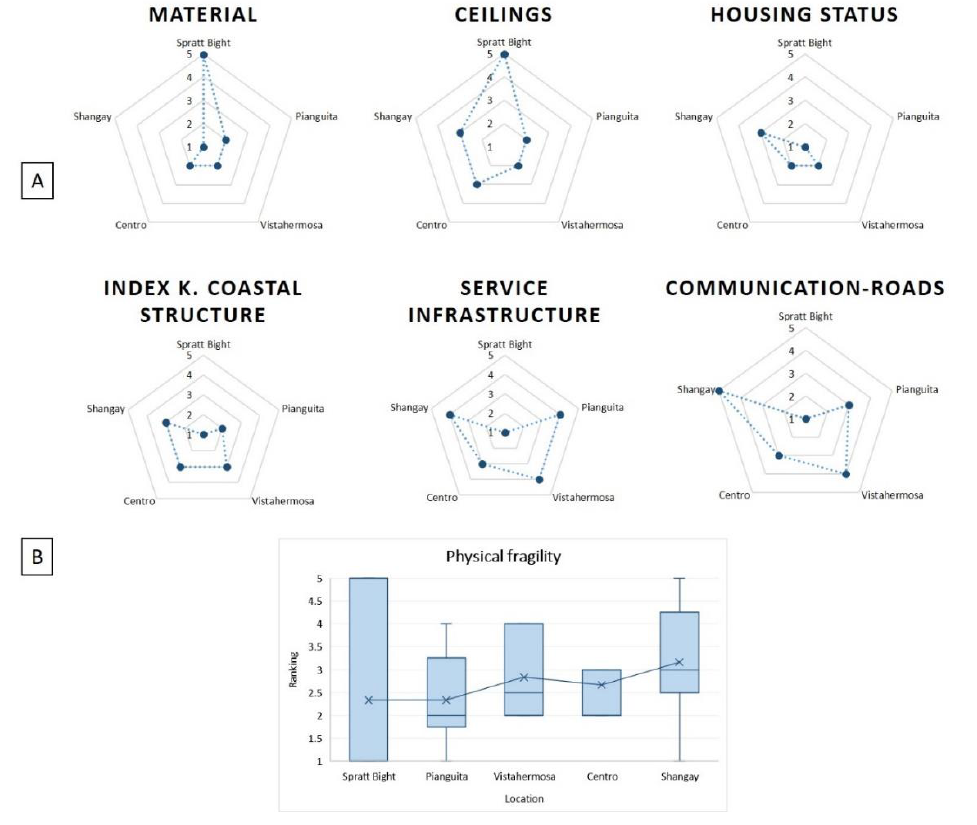
Figure 8. ( A ) Ranking of four variables representing physical fragility for two study areas (and five villages): San Andrés, Caribbean Coast (Spratt Bight) and La Bocana, Pacific Coast (Pianguita, Vistahermosa, Centro, Shangay) of Colombia. ( B ) Minimum and maximum values of physical fragility for each village and average rank. Results are shown by ranking, given that units of analysis are rank levels and not segments, as was the case for hazard.